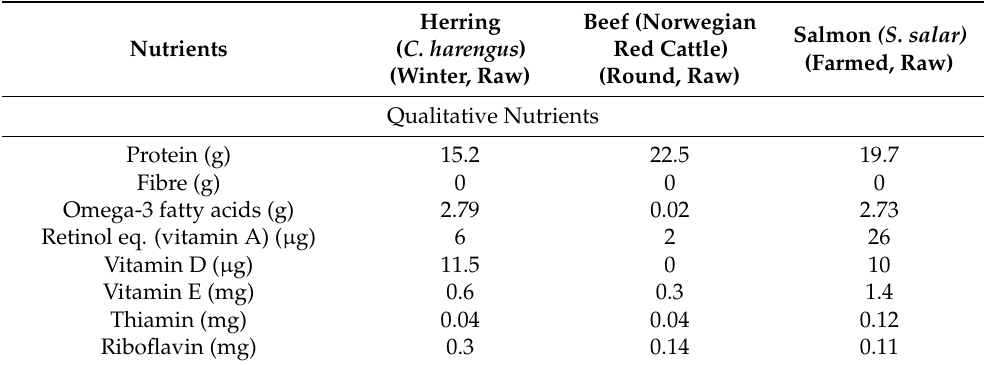
Table A2. Amount of micro- and macronutrients per 100 g wet weight of Atlantic Herring ( C. harengus ) filet, Norwegian beef round steak (Norwegian Red (dual purpose cattle)), and At- lantic salmon ( S. salar ) filet. Nutrients were adopted from [38] and nutrients categories were adapted from